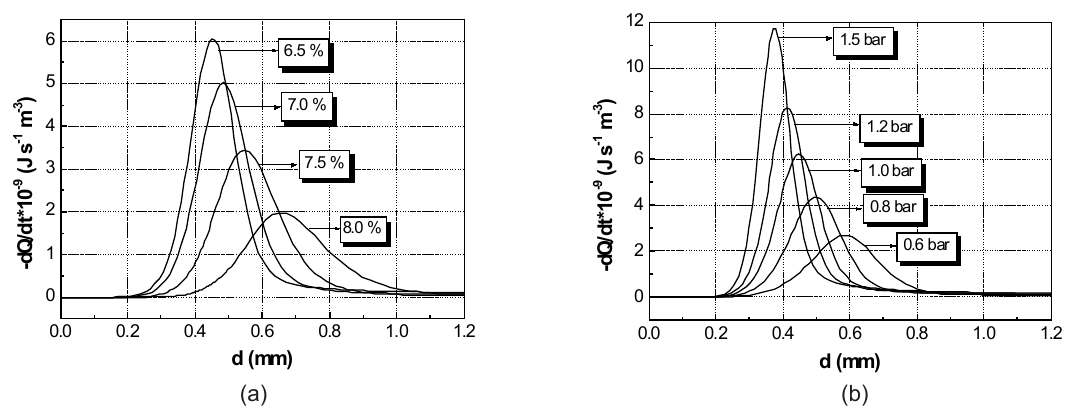
H -air mixtures, at T 2 6